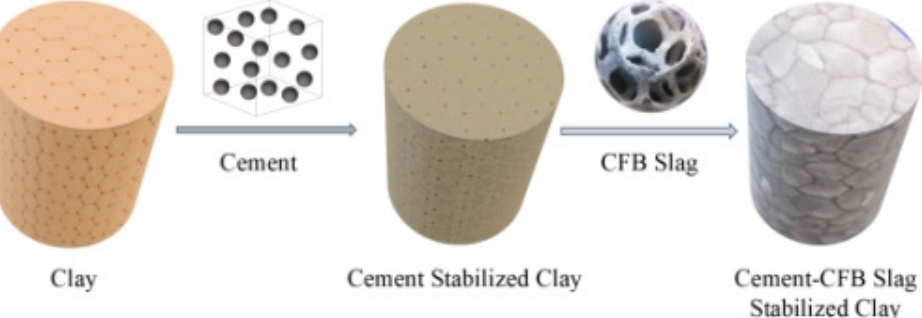
Figure 12. Crystal model of cement(–CFB)-slag-stabilized clay.